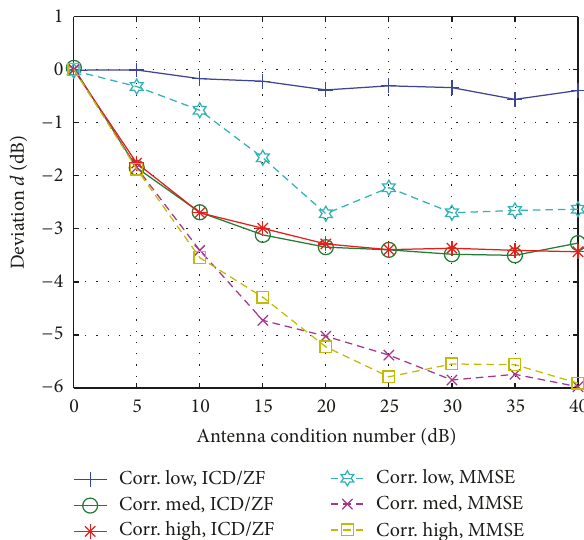
Figure 11: Deviation 𝑑 versus antenna condition number for DLSCH processing on, nonideal channel estimation; low, medium, and high channel correlation; ICD/ZF and MMSE receiver.